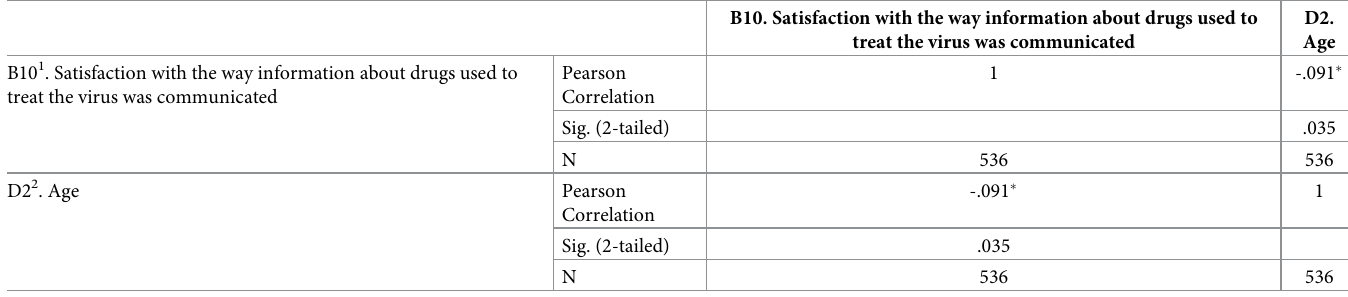
� . Correlation is significant at the 0.05 level (2-tailed).